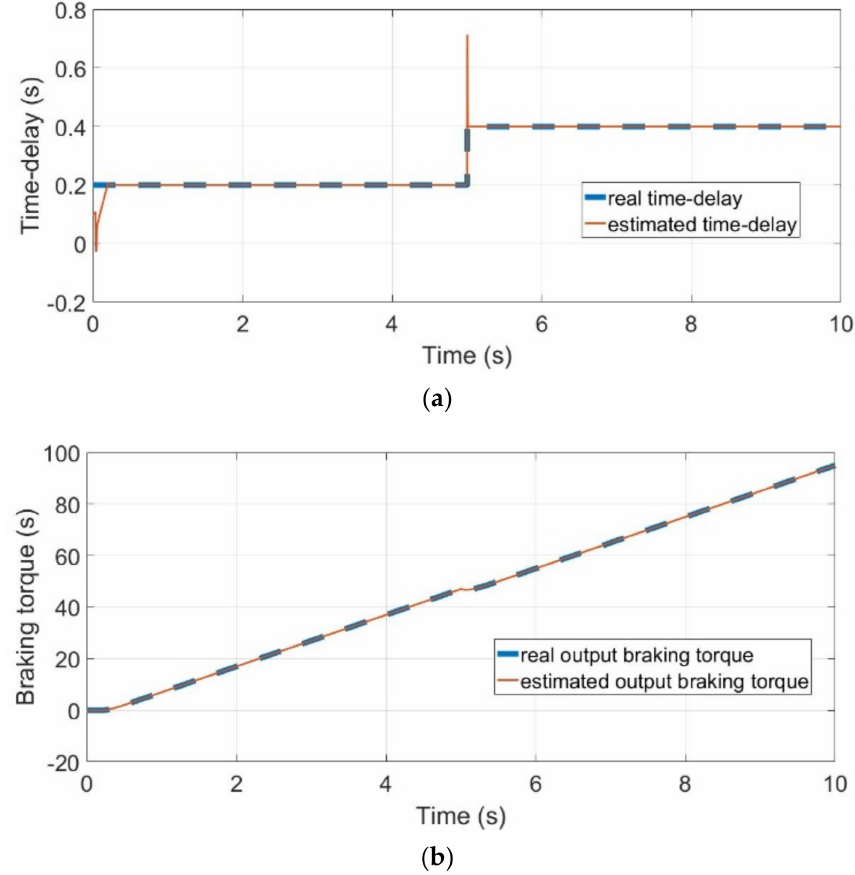
Figure 7. ( a ) Time − delay estimation when the input time-delay is a variable step signal. ( b ) Braking torque estimation when the input time-delay is a variable step